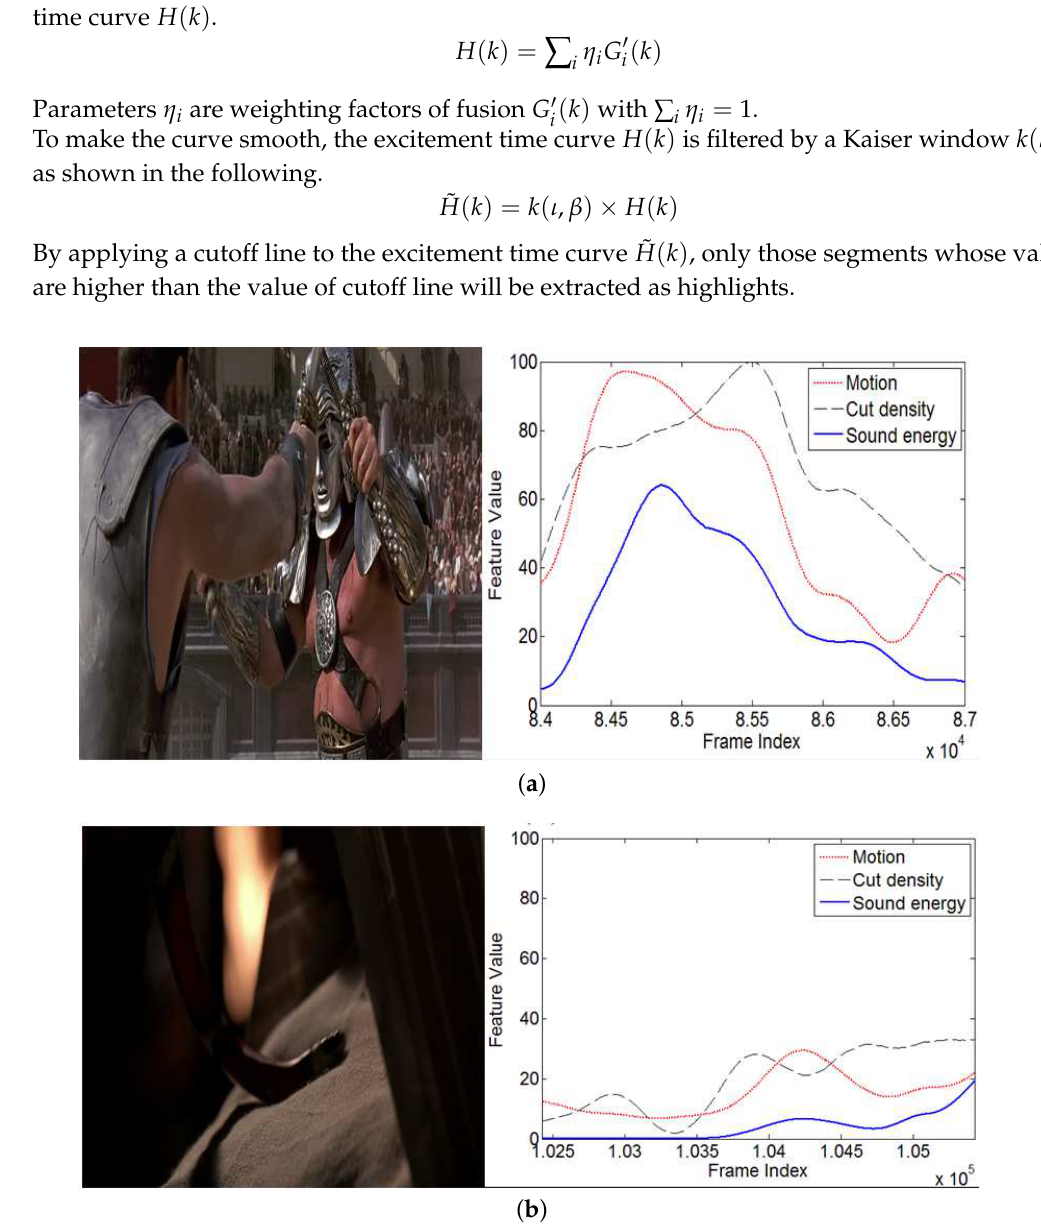
Figure 4. Examples of two exciting events with different feature curves. The low-level feature curves (right column) are extracted from two minutes of neighbor segments, which are centered on the frames corresponding to the screenshots on the right, respectively. ( a ) Two gladiators are fighting; ( b ) the enemy is using a poisonous snake to murder